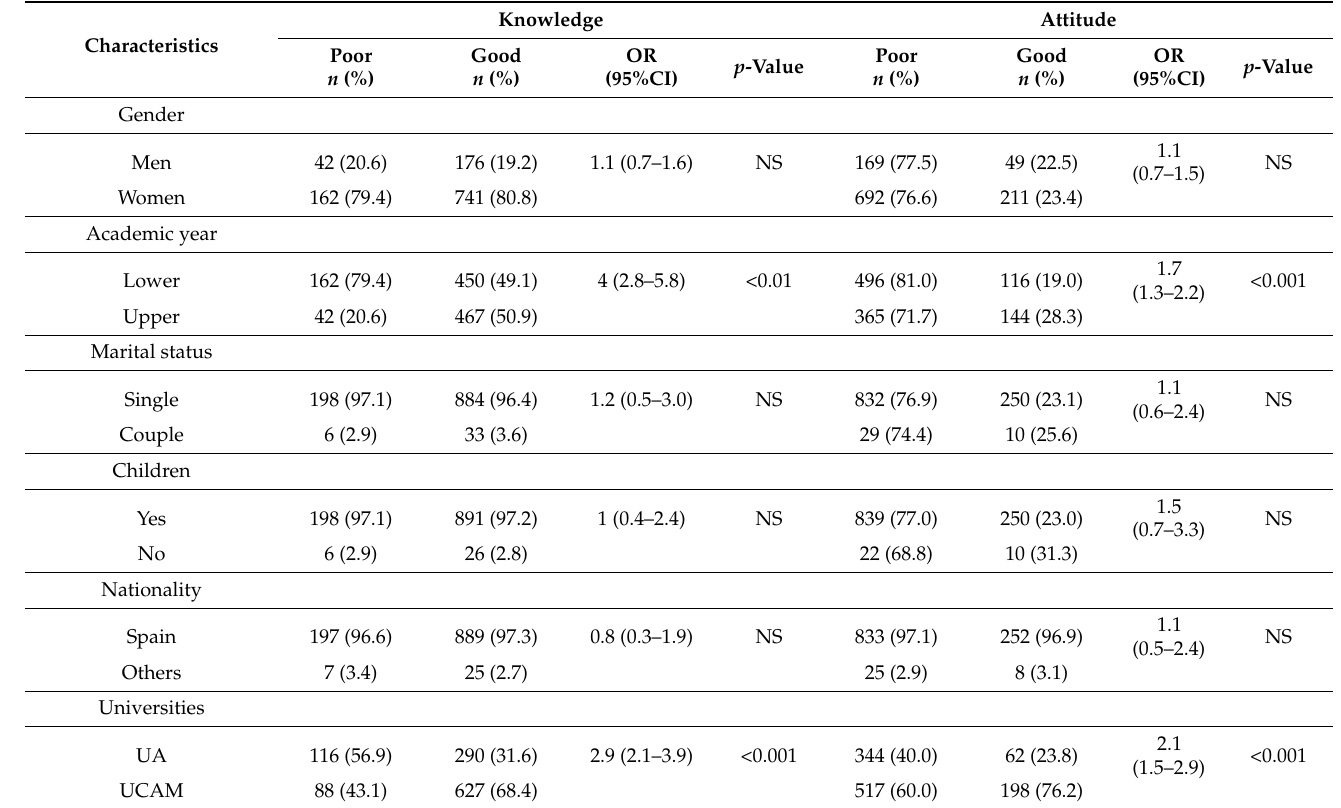
Table 3. Knowledge and attitude scores associated to demographics and population